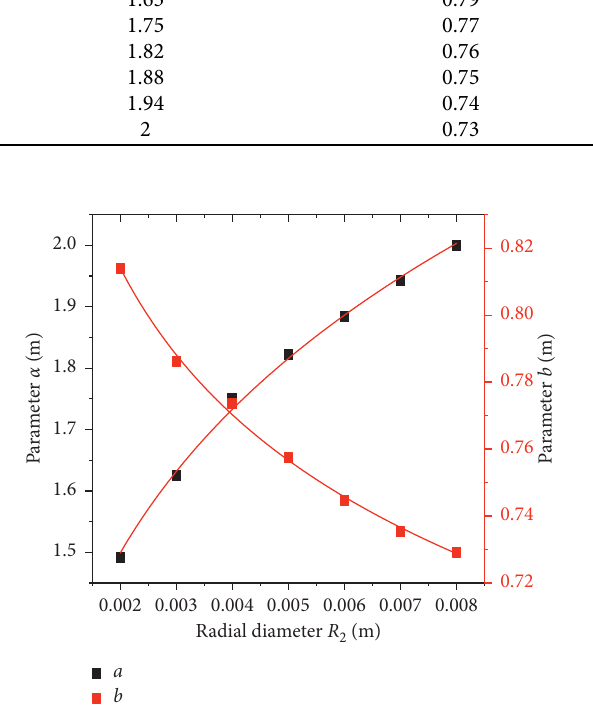
Figure 16: Fitting relation between parameters a and b and the inner diameter of radial flow.